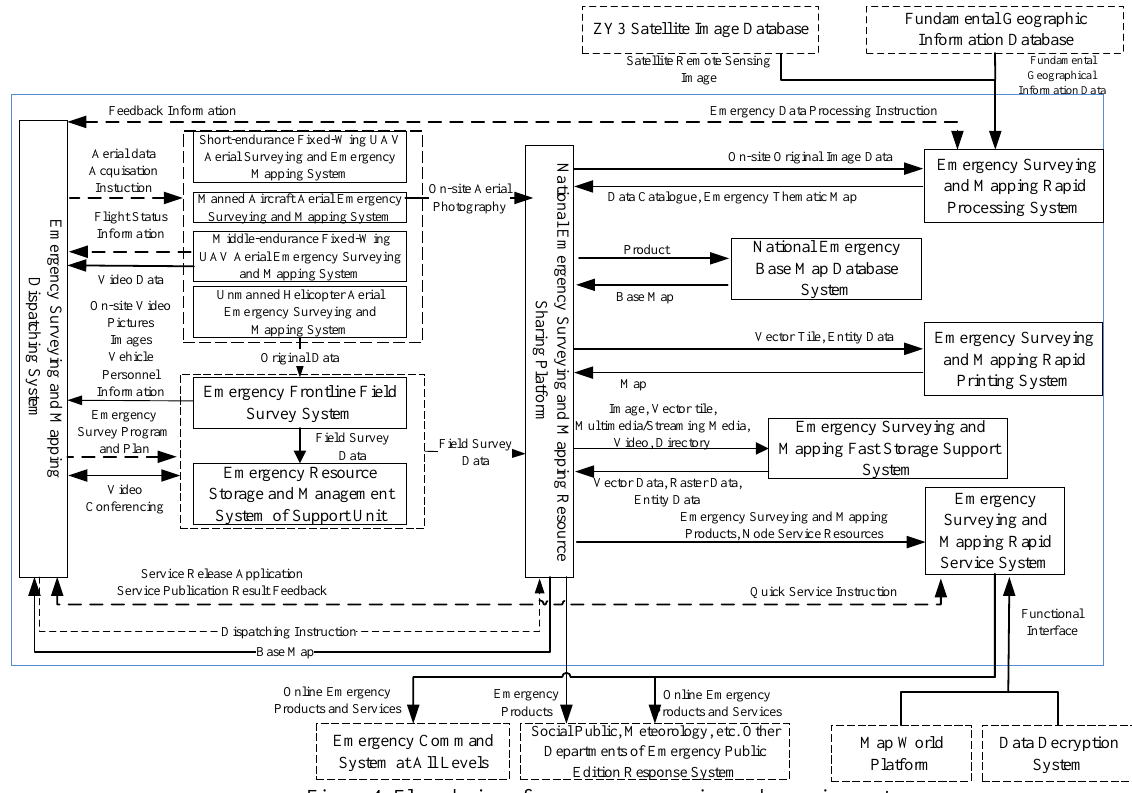
Figure 4. Flow design of emergency surveying and mapping